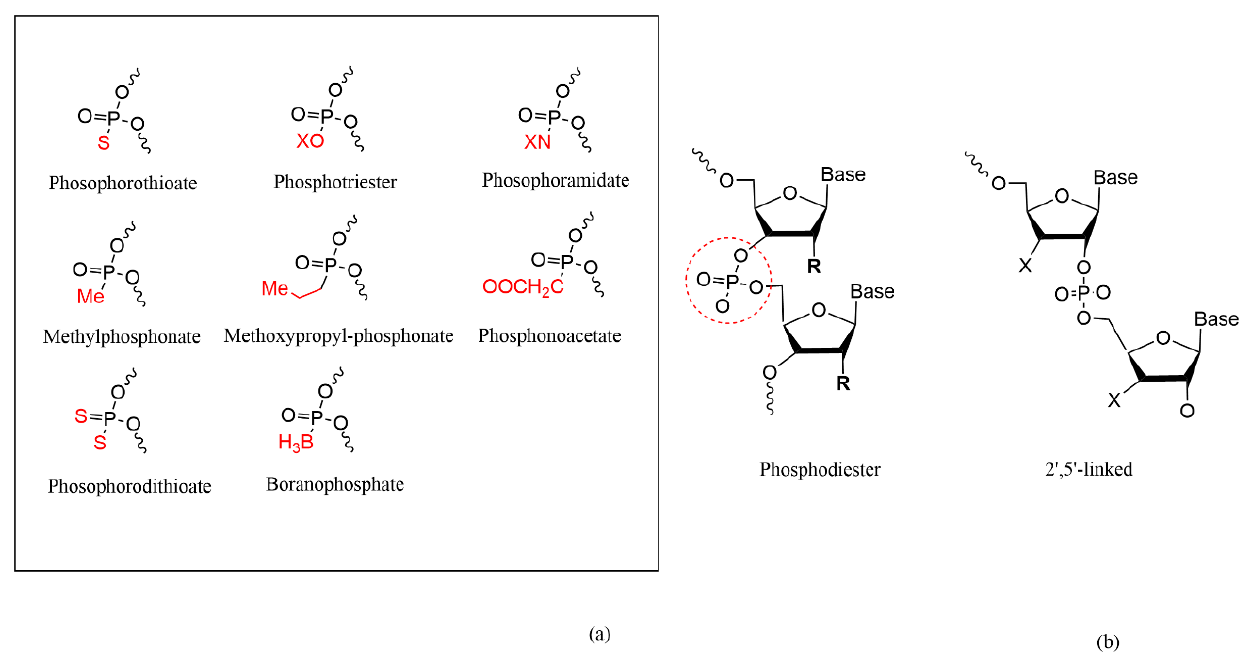
Figure 4. Chemical modification types of siRNA phosphate linkage. ( a ) The modifications of phosphodiester bond; ( b ) The modification of 2 ′ , 5′ -phosphodiester linkage.